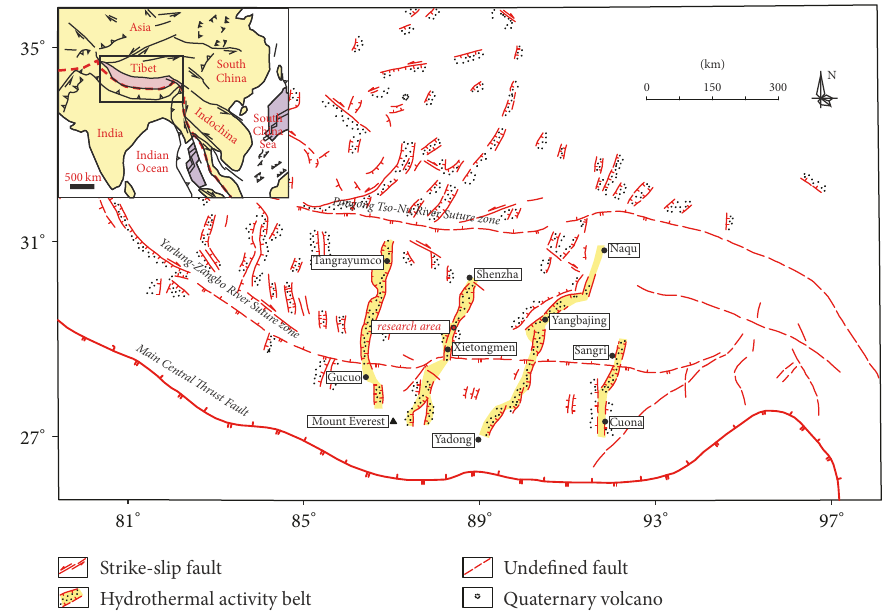
Figure 1: Distribution of hydrothermally active belts on the Tibetan Plateau